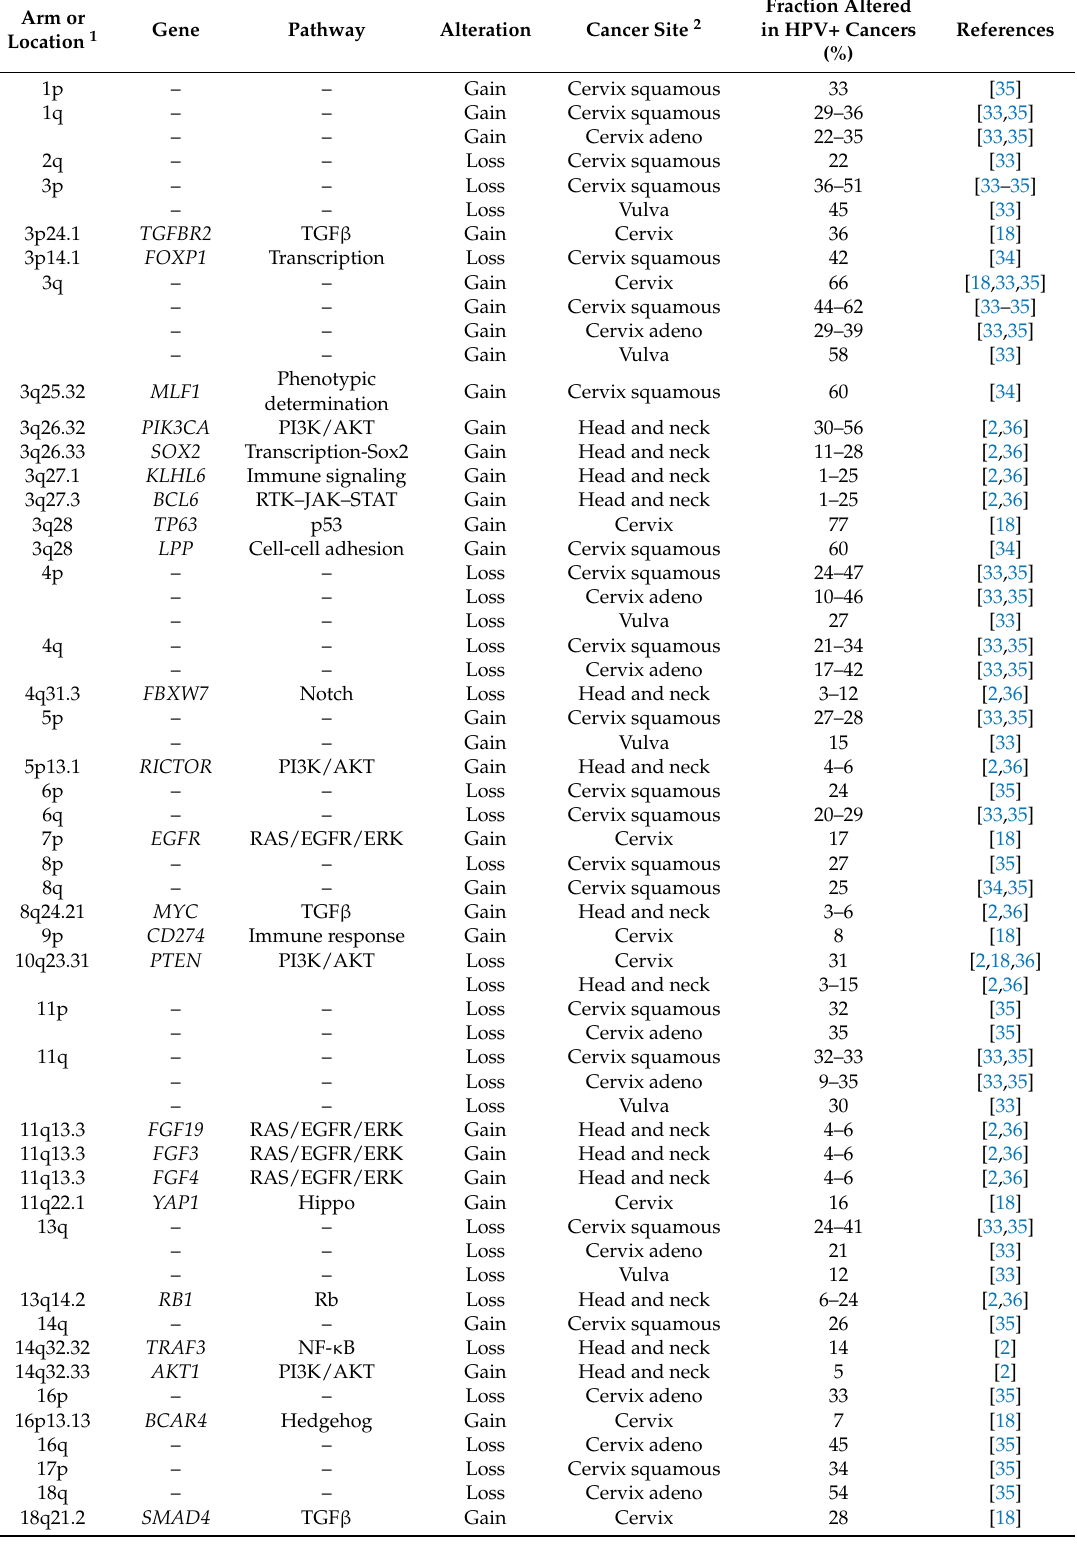
Table 1. Common copy number alterations in HPV-driven